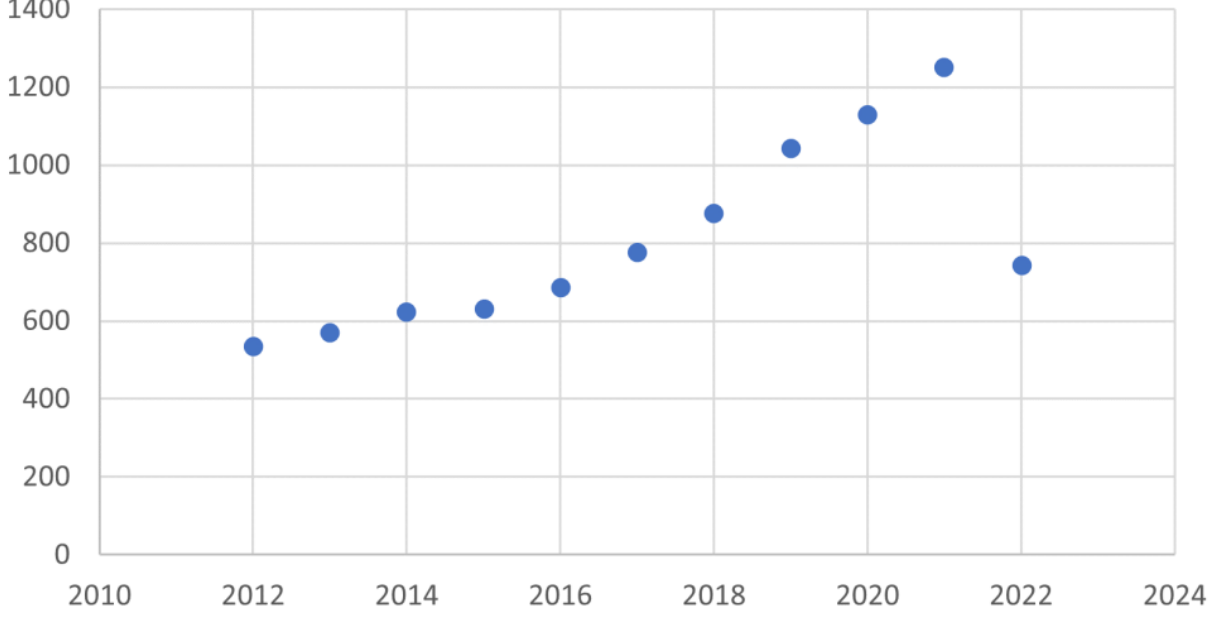
Table 4. Number of papers published in different countries (frequency > 5). Number Year First Published